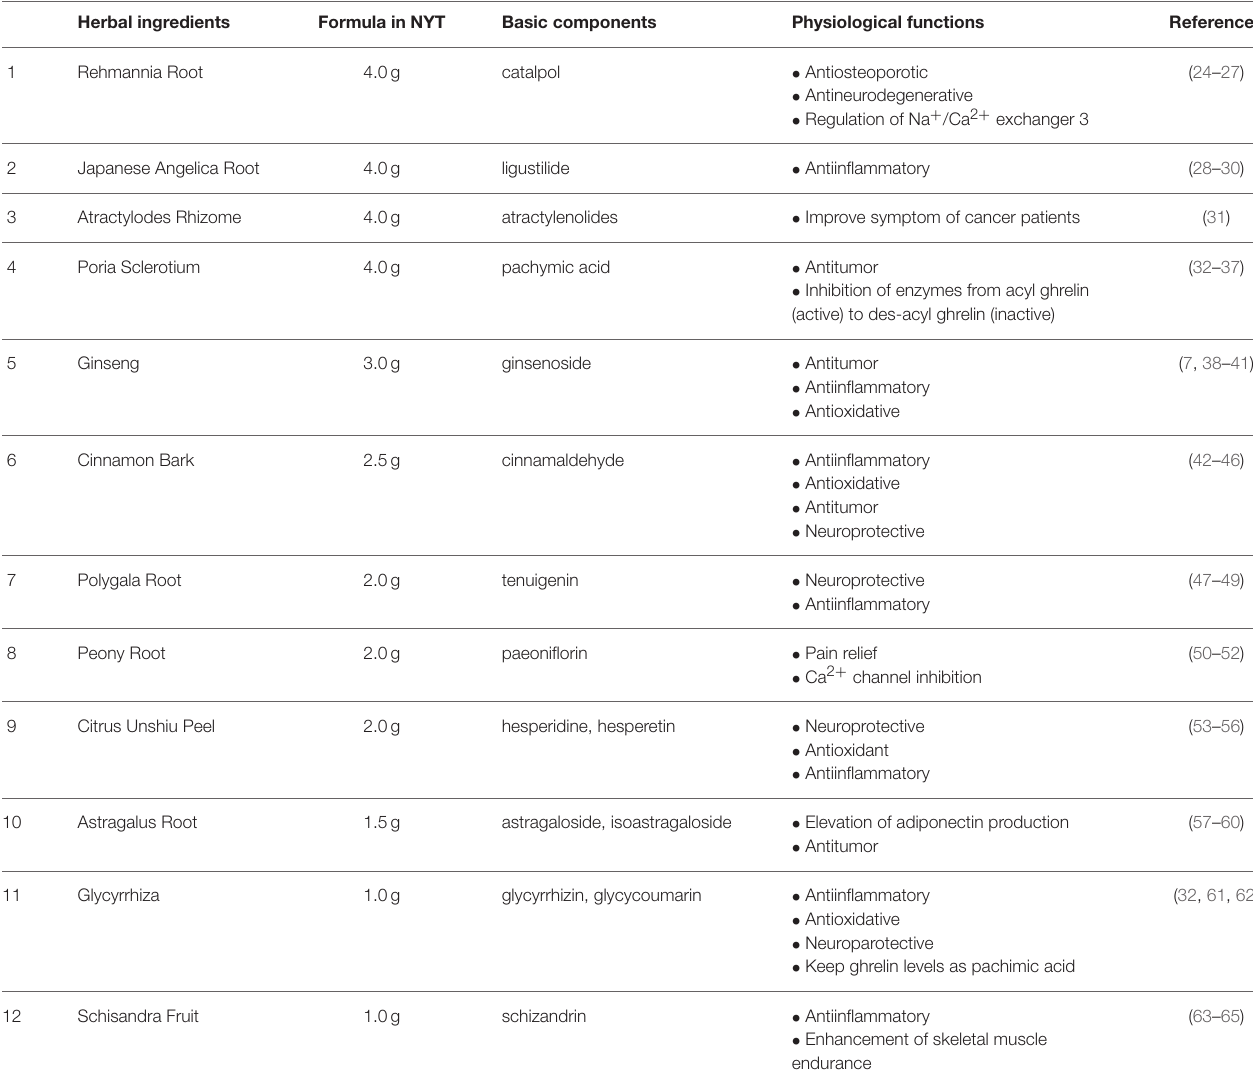
TABLE 1 | Physiological functions of basic components from each ingredients in